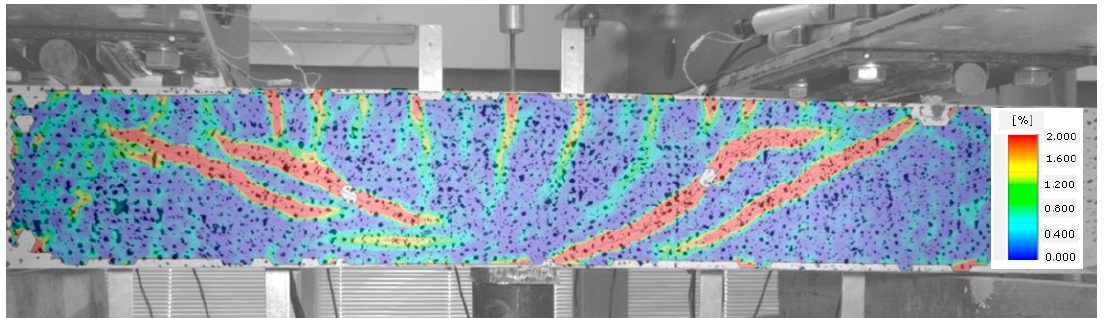
Figure 11. Stage III of shear behavior of element—occurrence of diagonal cracks in both shear areas.